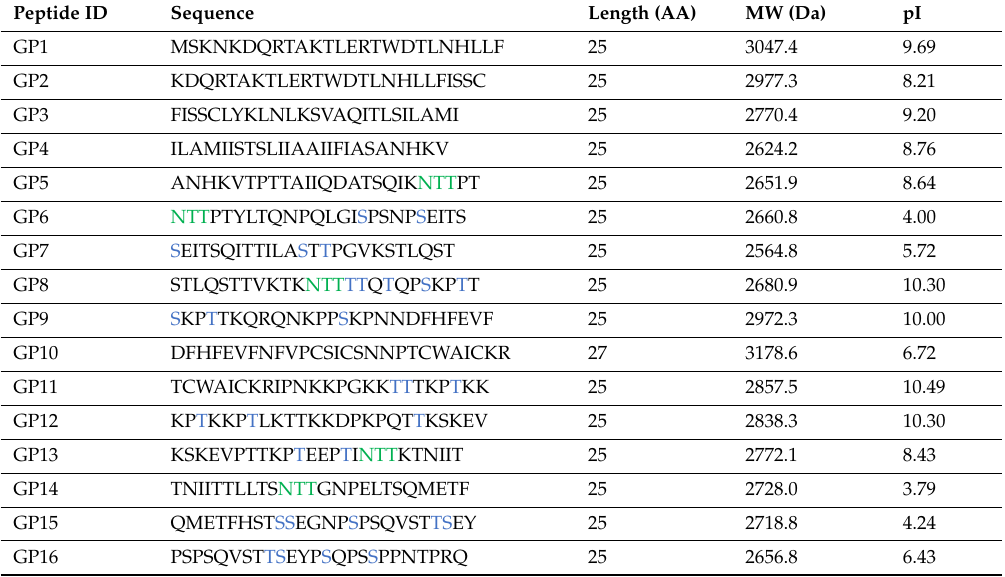
Table 1. Sequences and characteristics of G-derived synthetic peptides (GP1-GP16). N-linked (green) and O-linked glycosylation sites (blue) are indicated. Shown are the sequences, lengths, molecular weights (MWs), and isoelectric points